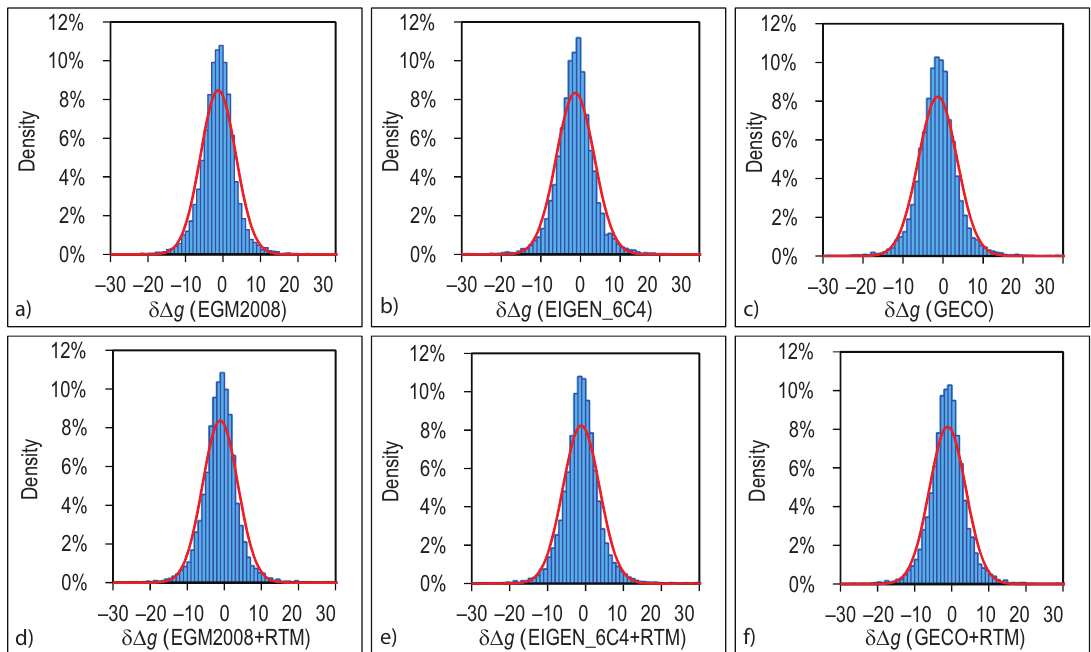
Figure 4. Histograms of gravity anomaly differences for combined GGMs up to d/o 2,190 and normal distributions from the same μ and σ (Red). Before SEM: a – EGM2008; b – EIGEN_6C4; c – GECO. After SEM: d – EGM2008; e – EIGEN_6C4; f –